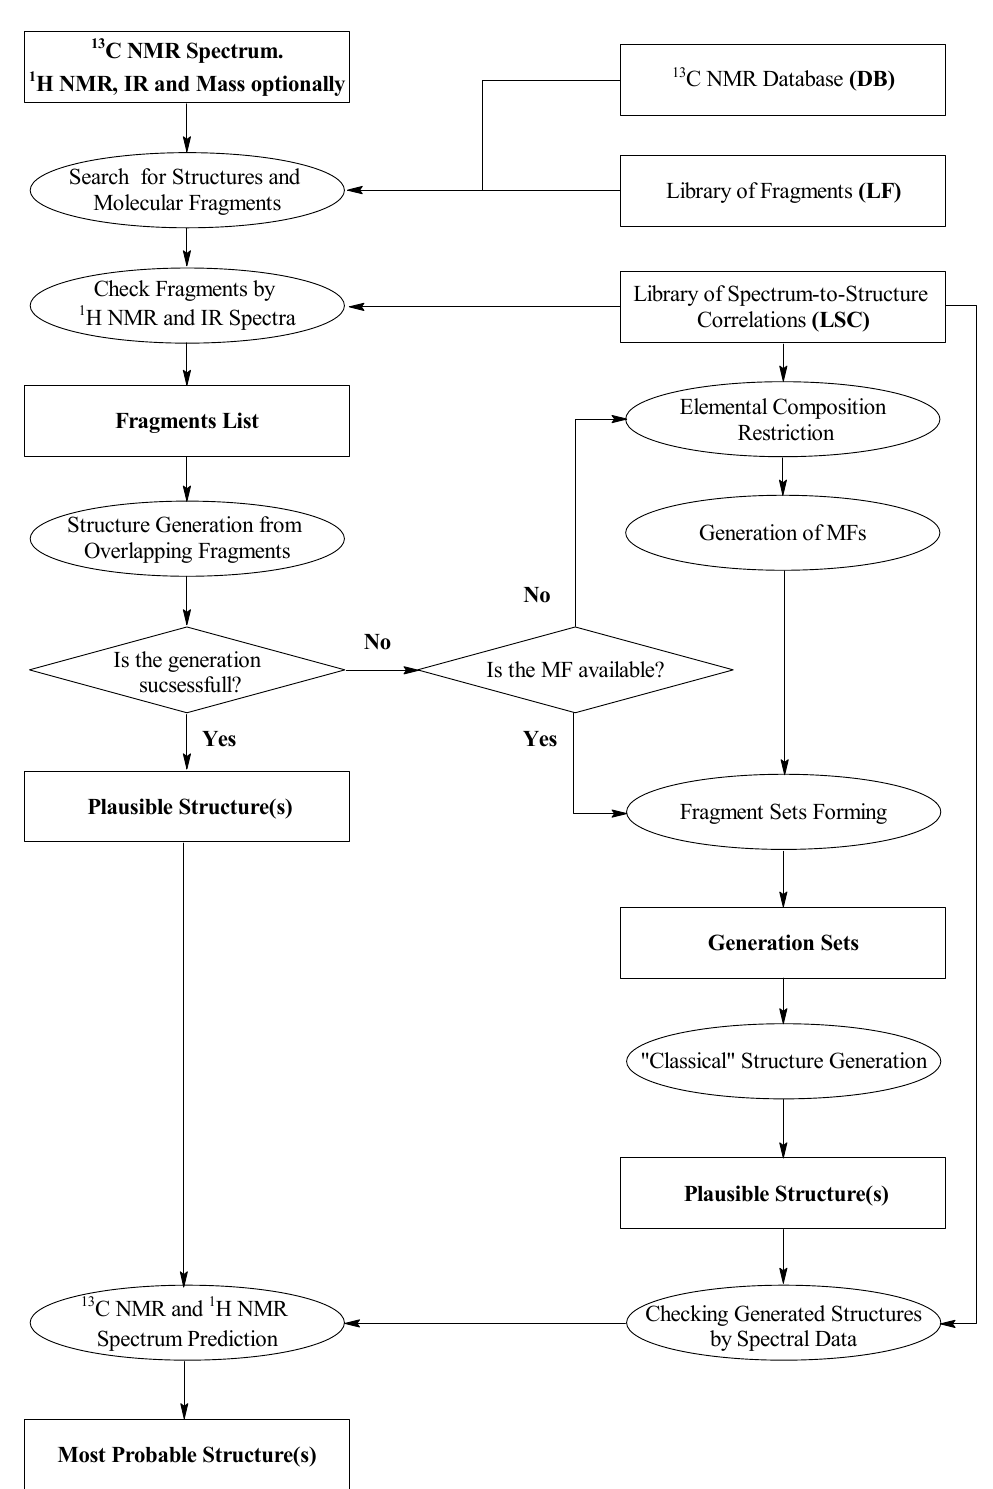
Figure 1. Flow diagram of ACD/SE_v1 based on 1D 13 C NMR spectra. During the first stage, the system tried to automatically determine the structure of the unknown compound using fragments found as a result of the Library of Fragments search based on the 13 C NMR spectrum. The resultant structure set was then generated by overlapping and joining fragments that had common atoms . Knowledge regarding the molecular mass and the molecular formula were not needed for this